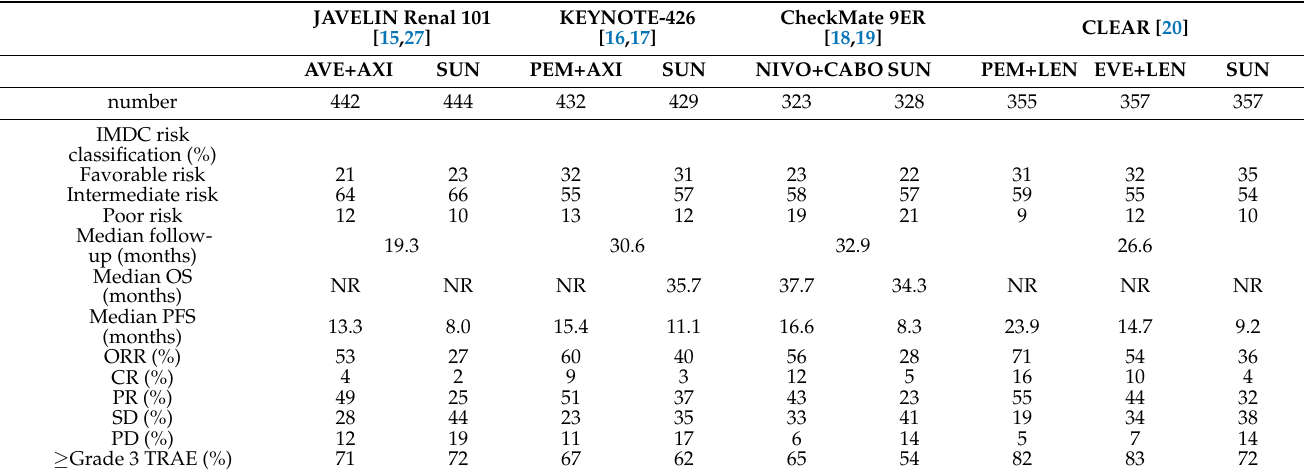
Table 5. Summary of a phase III study of combination therapy with immune checkpoint inhibitors and tyrosine kinase inhibitors for metastatic renal cell